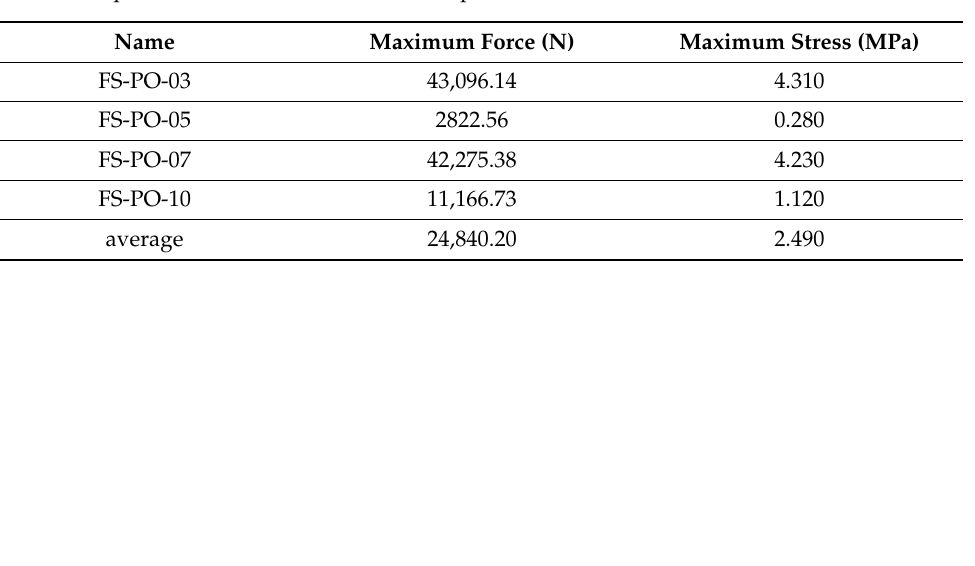
Table 2. Compression test of beech sawdust